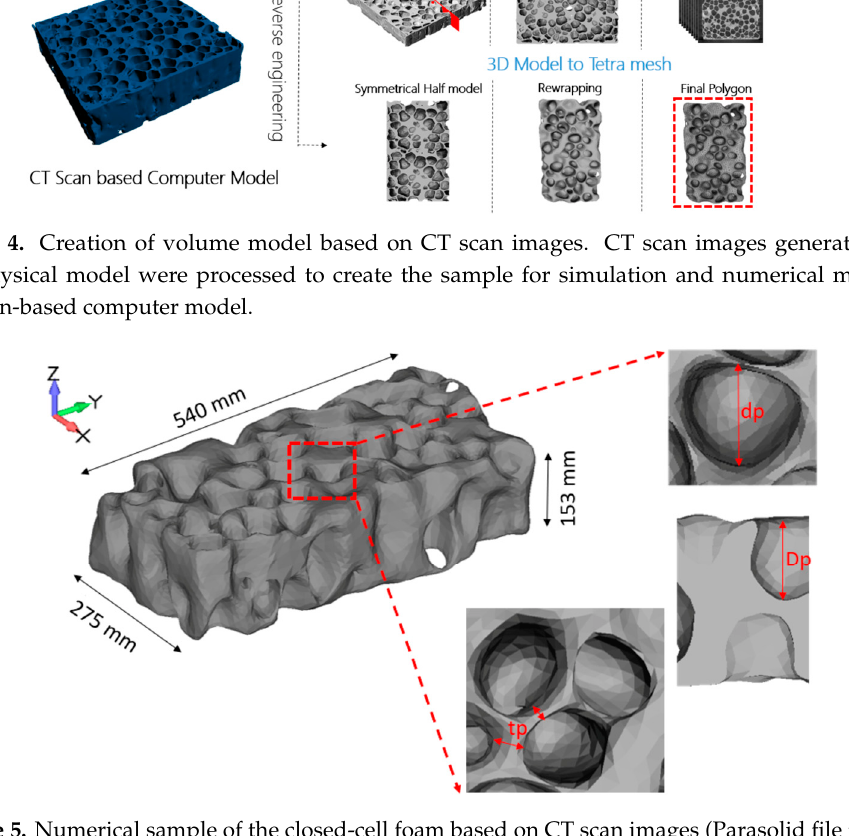
Figure 5. Numerical sample of the closed-cell foam based on CT scan images (Parasolid file format). Table 1. Properties of the numerical sample.